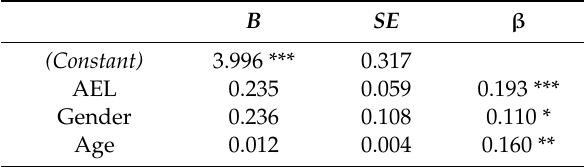
Table 2. Work engagement and supervisors’ active-empathetic